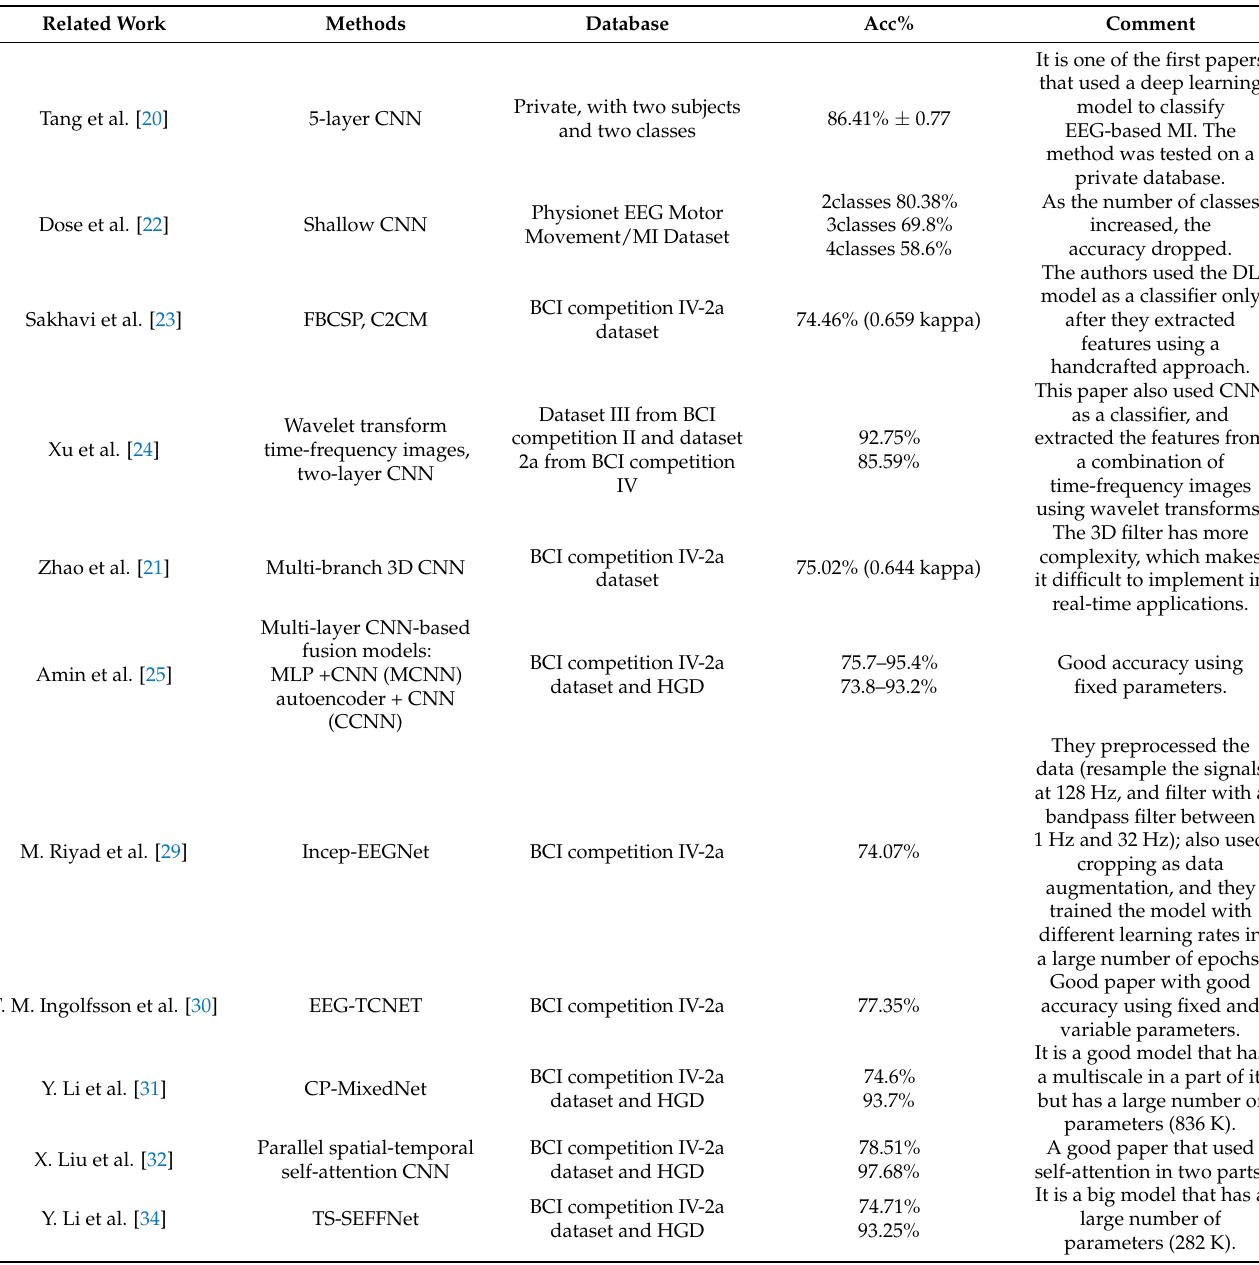
four classes: left means the left hand, right means the right hand, down means feet, and up means tongue. The arrow stayed in place for 1.25 s, prompting the subject to complete the desired class. When the fixed cross on the screen vanishes, this means that the subjects can relax and the trial is finished. Each trial was followed by a 2-s pause in which the screen was black. Figure 2 depicts the timing pattern for each trial. Table 1. Summary of related